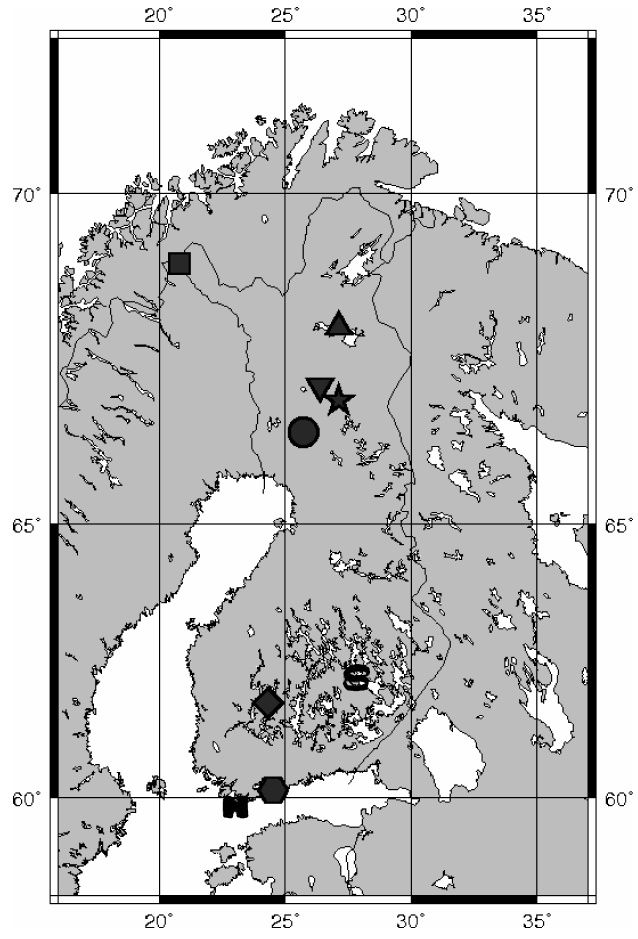
Figure 1. The locations of the measurements. From the bottom up, H = Hanko, hexagon = Masala, diamond = Hyytiälä, S = Suonenjoki, circle = Rovaniemi, star = Pyhätunturi, downward pointing triangle = Sodankylä, upward pointing triangle = Vuotso, square = Kilpisjärvi. Helsinki is 20 km east of